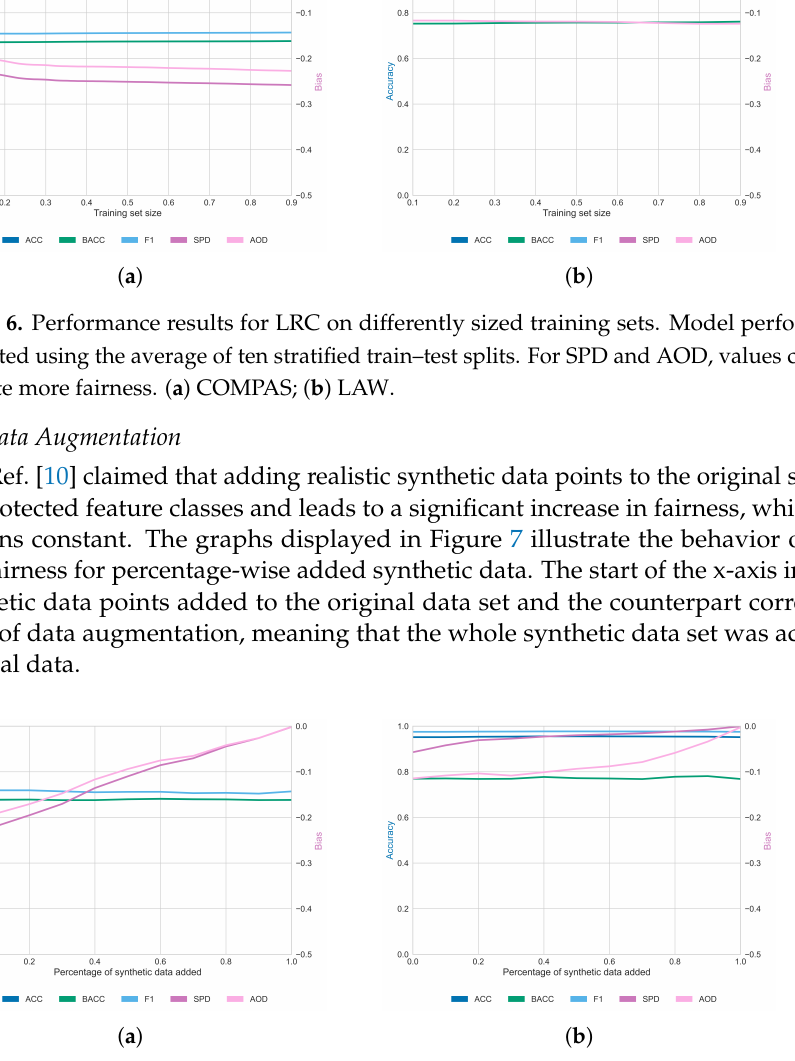
Figure 7. Performance results for the LRC on augmented data. Synthetic data points are added to the training and test sets for evaluation. Performance was evaluated using stratified 10-fold CV. For SPD and AOD, values closer to zero indicate more fairness. ( a ) COMPAS; ( b )